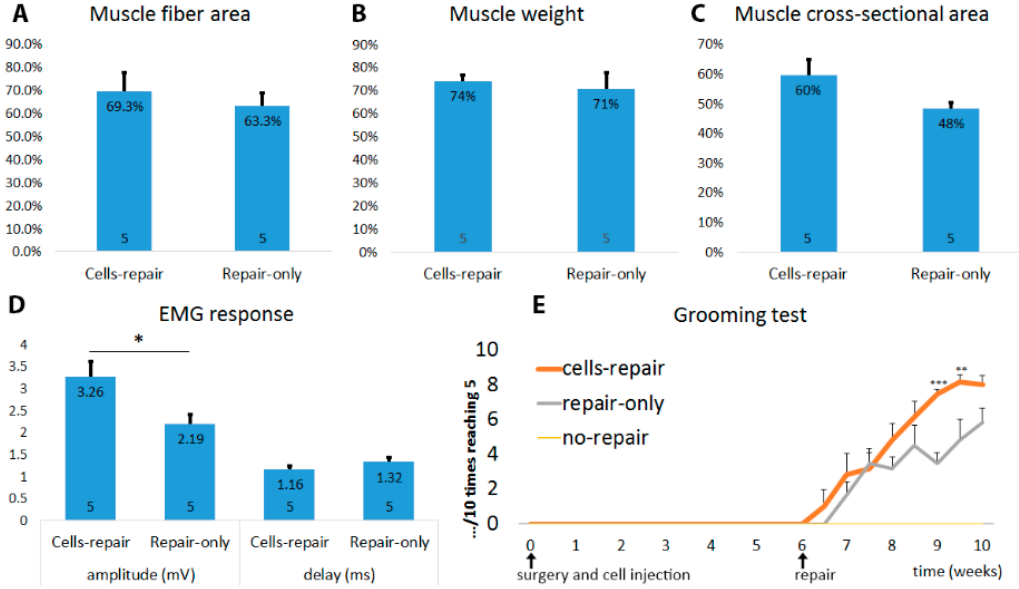
Figure 9. Delayed repair after the injury helped to stop the muscle atrophy, while cells did not significantly increase this positive effect. ( A ) Analysis of muscle fiber area; ( B ) Analysis of muscle weight; ( C ) Analysis of muscle cross-sectional area; ( D ) The muscles in both repair groups were able to evoke EMG response, whereas response in the cells-repair group was significantly higher compared to the repair-only group. Response delay was also slightly improved with cell transplantation. Data is shown as mean + SEM. * p < 0.05. The number of animals in each group is shown inside the bar base; ( E ) Grooming test showed that animals without repair did not recover their elbow flexion function while animals who received 6 weeks delayed repair all recovered their elbow function. Interestingly, the cells-repair group showed slightly earlier functional recovery. ** p < 0.01, *** p < 0.001. Data is shown as mean + SEM. Grooming test results are shown for 6 animals per group.